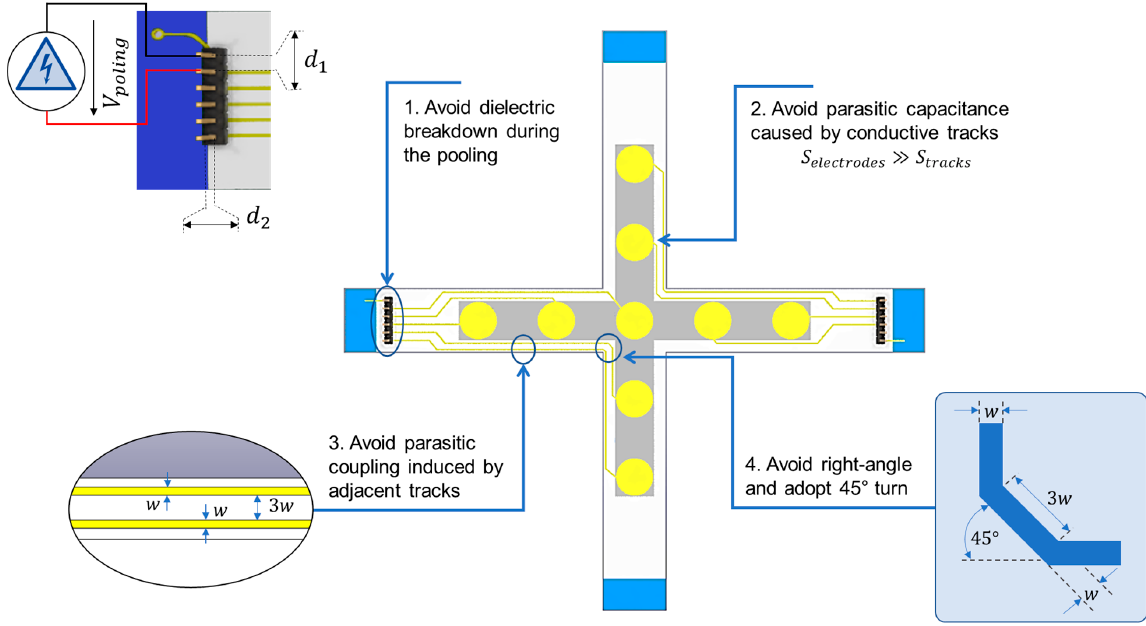
Figure 2. Four principal rules of sensor network